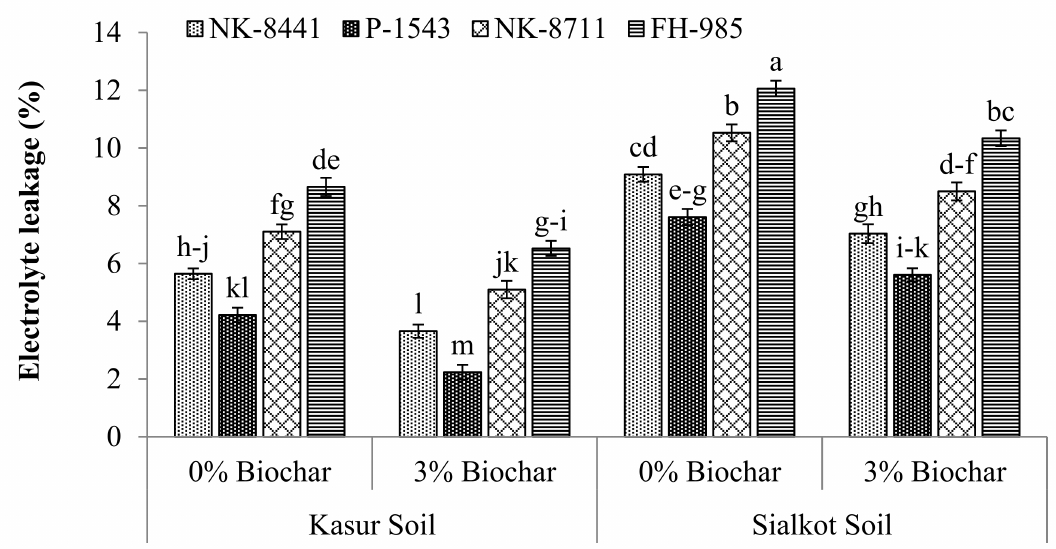
Figure 2. Electrolyte leakage of studied maize cultivars with the application of biochar in the tannery polluted soils of Kasur and Sialkot. Mean values are indicated by columns and the standard error of the mean is shown with bars. All means followed by different letters are significantly different ( p < 0.05) according to Tukey’s HSD